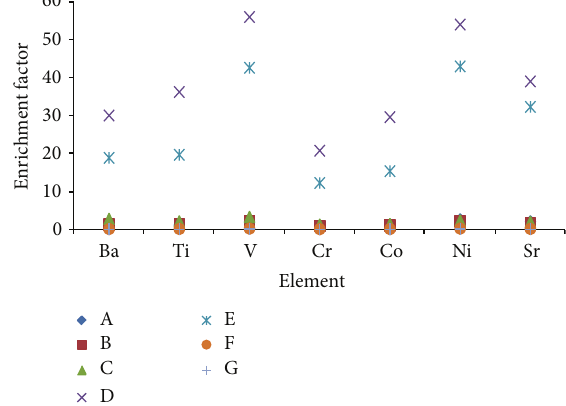
Figure 8: Enrichment factors of Cu, Zn, and As at the seven sampling